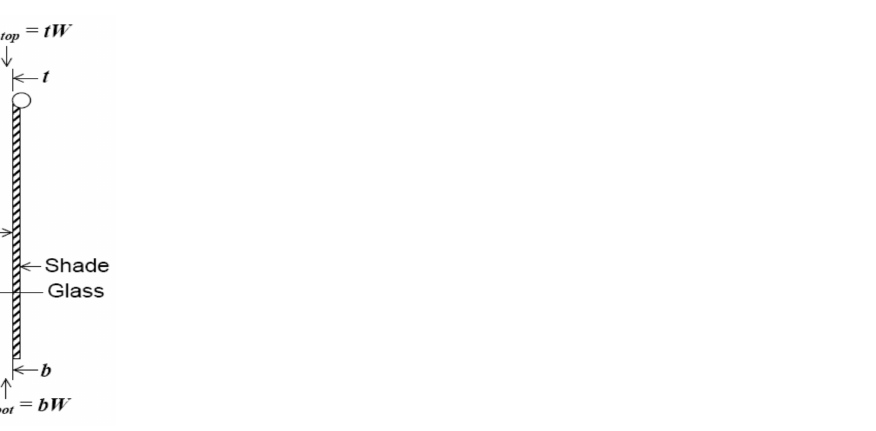
Figure 3. Configurations of external windows shading devices applied in the study (From DesignBuilder). Table 3. Rolling window shutters description